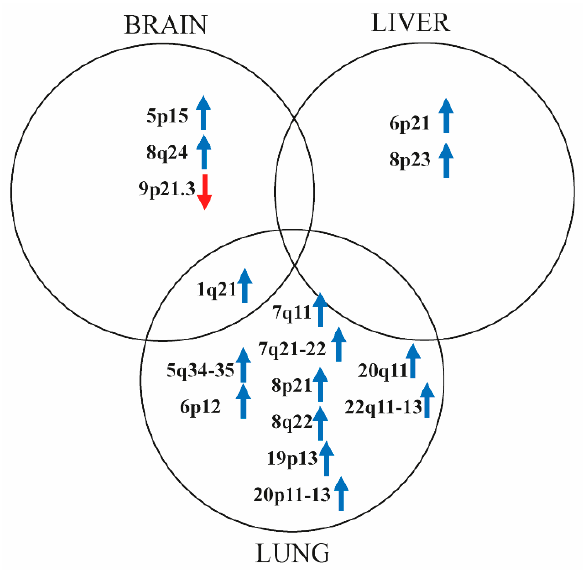
Figure 4. Shared and specific chromosomal regions distorted by high-copy number gains (CN ≥ 4) and homozygous losses. Blue and red arrows represent copy number gains and number losses, respectively.